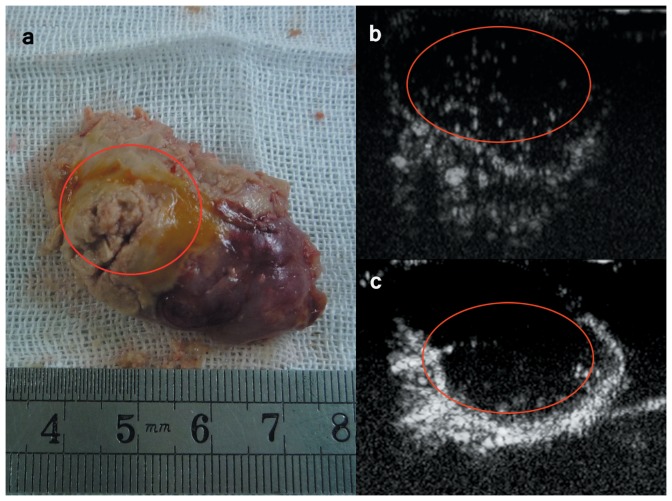
Contrast-enhanced dynamic images of nanobubbles carrying AR siRNA in a C4-2 prostate cancer xenograft model.(A) A xenograft tumor specimen; (B) ultrasonic imaging of a C4-2 xenograft after the injection of nanobubbles carrying AR siRNA using a Philips iU22 ultrasound system; and (C) ultrasonic imaging of a C4-2 xenograft after the injection of SonoVue micron-sized microbubbles as a control. The region marked with a red circle in the three panels represents the central hypovascular area of the tumor. The nanobubbles carrying AR siRNA achieved stronger signals than SonoVue in this area.